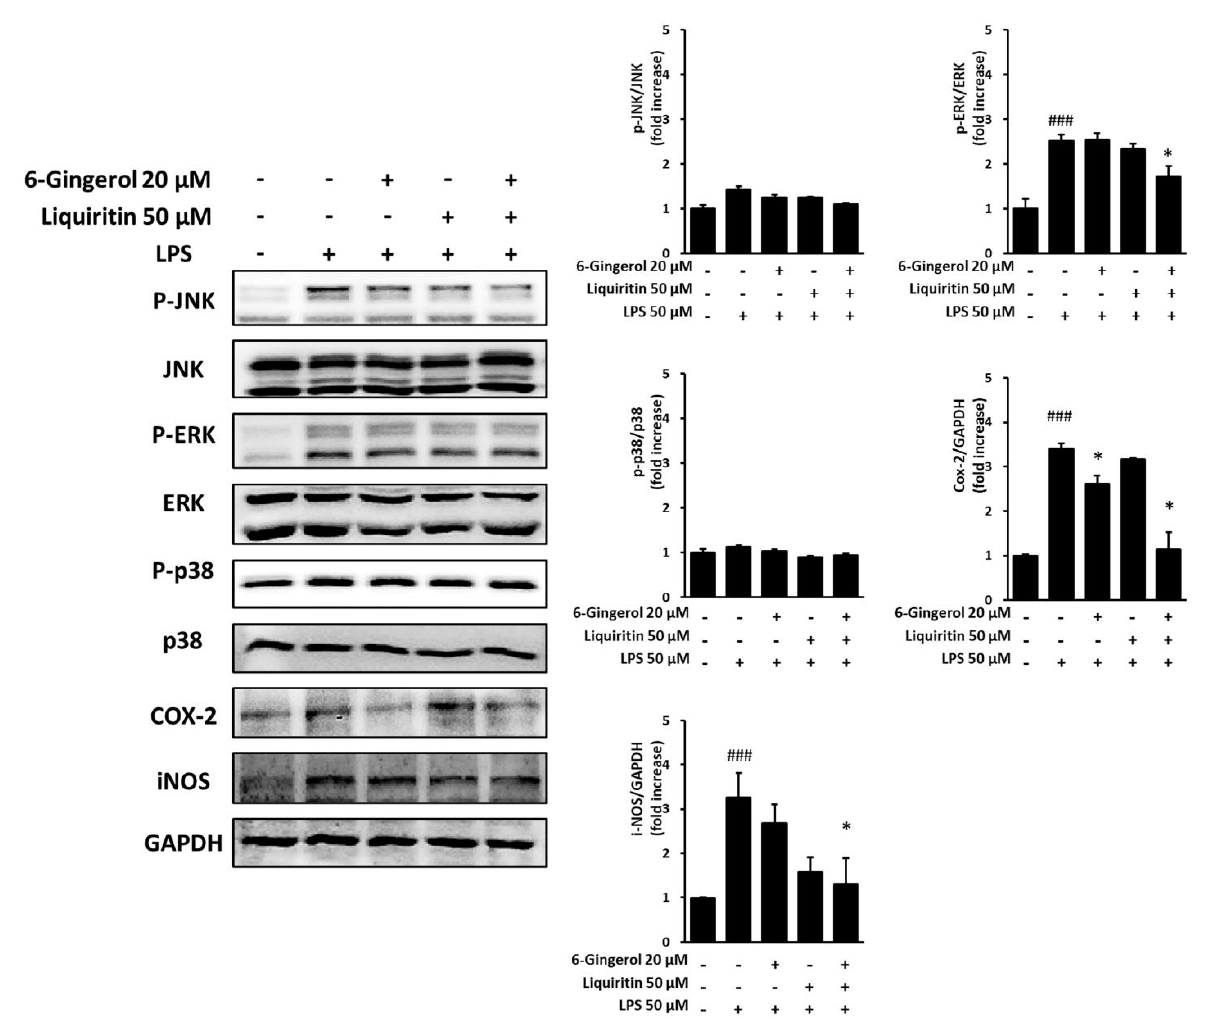
Figure 5. Inhibitory effects of liquiritin and 6-gingerol on the protein expression levels of p-JNK, p-ERK, p-p38, COX-2, and iNOS in RAW 264.7 cells. The cells were pre-treated with various concentrations of liquiritin and 6-gingerol, following which the cells were treated with LPS (100 ng/mL) for 20 h. The phosphorylation levels of p-JNK, p-ERK, p-p38, COX-2, and iNOS were analyzed using Western blot. The data are presented as mean ± SEM. Statistical significance was assessed by means of ANOVA followed by Tukey’s post-hoc test, using software R version 3.3.3. ### p < 0.001, compared to the normal group; * p < 0.05, compared to the LPS-treated group.